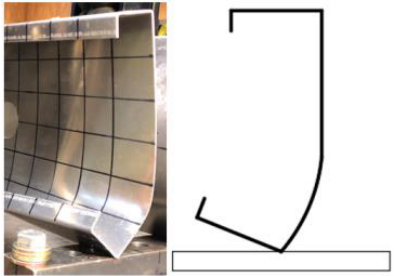
Figure 1. Web crippling failure at a reaction point